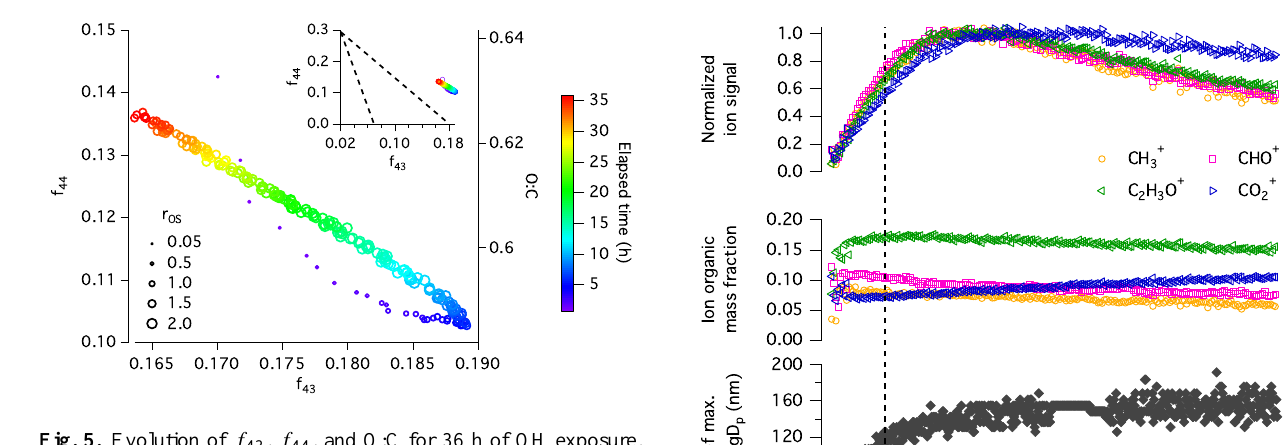
of the 4 dominant organic ions (CH + , CHO + , C 2 H 3 O + , and 3 CO + ) in the aerosol mass spectra and the maximum of the 2 suspended particle size distribution throughout 36 h of oxi- dation. Excluding CO + , these ions account for 30–35 % of 2 the total organic signal throughout the experiment. When or- ganic CO + and the ions whose organic contributions are as- 2 . sumed to correlate with it (CO + , H 2 O + , OH + , and O + ) are 2 included, the mass fraction of the organic signal is approx- imately 52 %. In the top panel of Fig. 7, the time trends of the normalized, wall-loss corrected ion signals are shown. To obtain this, the ion signal was divided by the sulfate signal to correct for wall losses. The sulfate-normalized ion signal was then scaled by its average value at the peak concentration. In the middle panel, the fractional contribution of each ion to the total organic signal is shown. The bottom panel shows the particle diameter ( D p ) of the maximum of the suspended par- ticle size distribution. The most rapid change in D p occurs during the first 5 h of irradiation. The amount of each of the 4 ions in the particles increases during this time (top panel). After 5 h, D p changes more slowly, and the contribution of each ion to the spectra begins to peak. CHO + reaches a max- imum most quickly, followed by CH + and C 2 H 3 O + . CO + 3 2 peaks later than the other ions. After most of the ions peak, their contribution to the spectra decreases for the